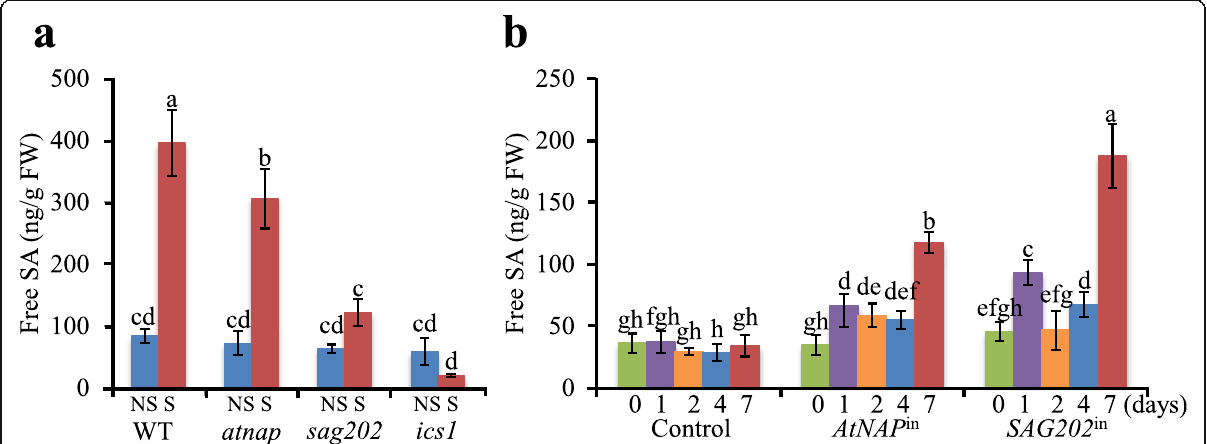
Fig. 6 LC-MS/MS analyses of free SA levels in WT, atnap , sag202 , ics1 null mutants, AtNAP in and SAG202 in lines. ( a ) Free SA levels in NS and S (~ 50% yellowing) leaves of WT, atnap , sag202 and ics1 mutants, respectively. ( b ) Free SA levels in young leaves of AtNAP inducible lines ( AtNAP in ) and SAG202 inducible lines ( SAG202 in ) at 0, 1, 2, 4, and 7 days after DEX induction. Error bars indicate SD of three biological repeats. Significant